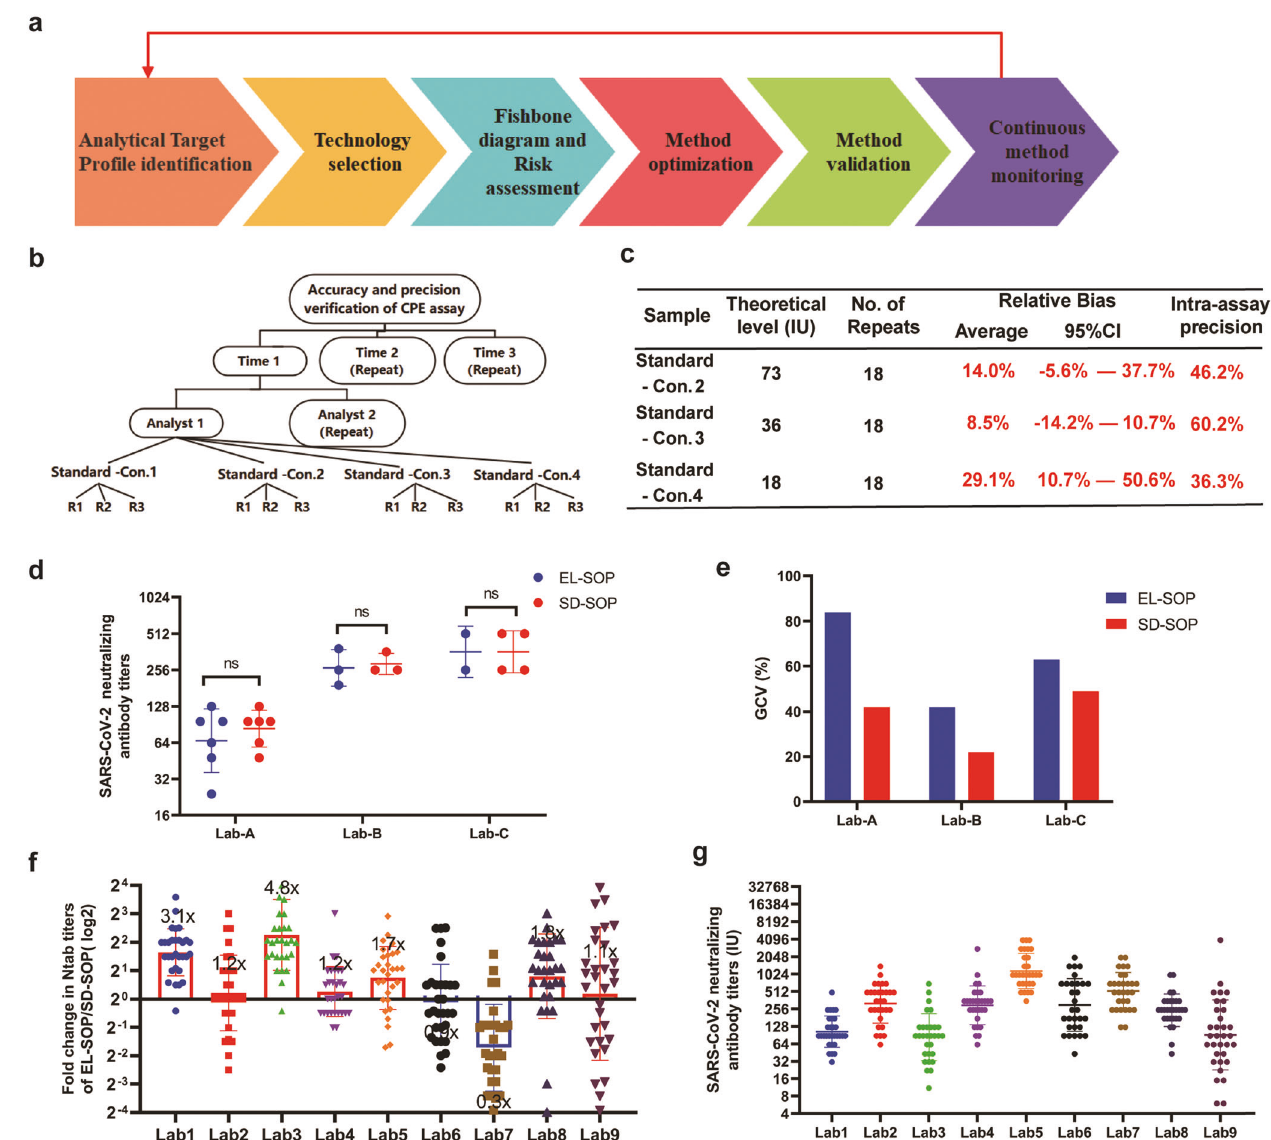
Fig. 1 Development and application of standardized neutralization antibody analytical procedure. a Schematic diagram of the AQbD approach for analytical procedure development in this study. b Relative accuracy and intermediate precision validation were performed on 3 different days by two analysts. Each analyst prepared their own four samples and performed the procedures independently on each day. c Results are displayed in tables. d Ntab titers of the national standard tested in three laboratories using SD-SOP and EL-SOPs. e GCV of Ntab titers of national standard detected in three laboratories using SD-SOP and EL-SOPs. f Fold change of EL-SOP/SD-SOP in Ntabs titers. g Ntab levels of clinical samples from patients subjected to COVID-19 vaccines and convalescent serum marked by IU. d , f , g Bars represent geometric means, and error bars represent geometric standard deviations for each group. ANOVA- t test was used to compare the difference between both groups, and ns represents no signi fi cant